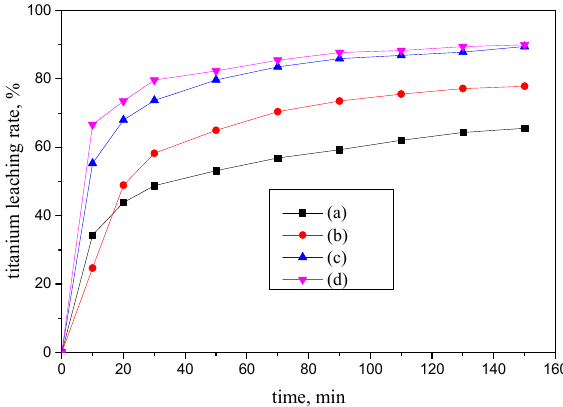
Figure 3. Ti leaching rates under four different conditions: ( a ) average particle size of 110.5 µm, reaction temperature of 513.15 K, and initial acid concentration of 88.0 wt %; ( b ) average particle size of 31.5 µm, reaction temperature of 453.15 K, and initial acid concentration of 88.0 wt %; ( c ) average particle size of 31.5 µm, reaction temperature of 513.15 K, and initial acid concentration of 88.0 wt %; ( d ) average particle size of 31.5 µm, reaction temperature of 513.15 K, and initial acid concentration of 98.0 wt %.